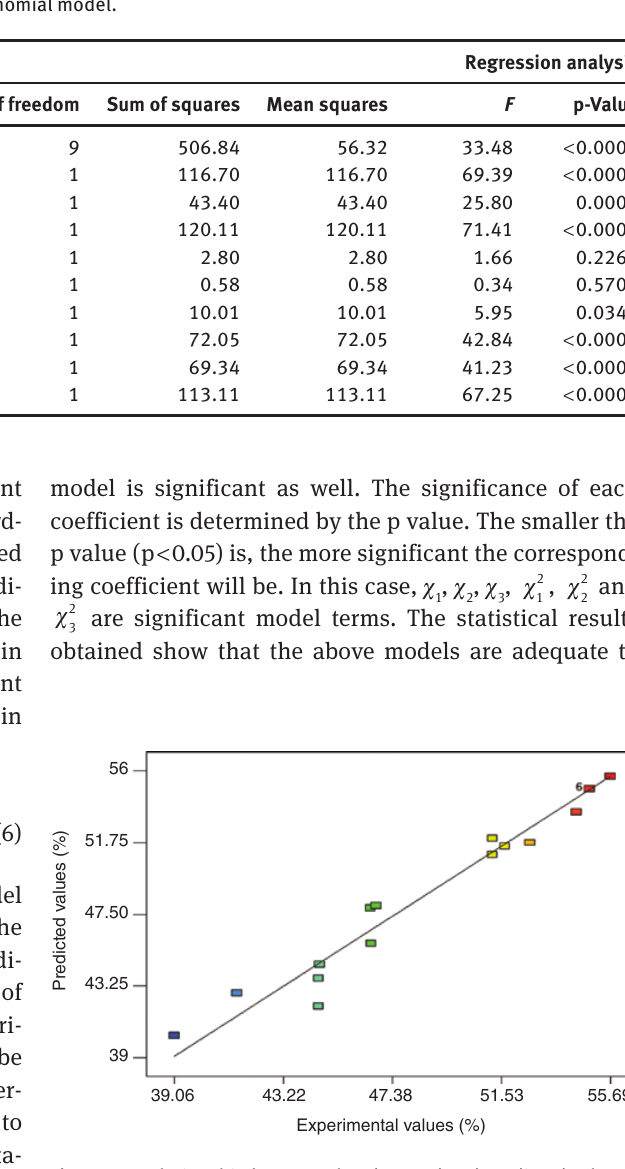
Figure 2: Relationship between the observed and predicted